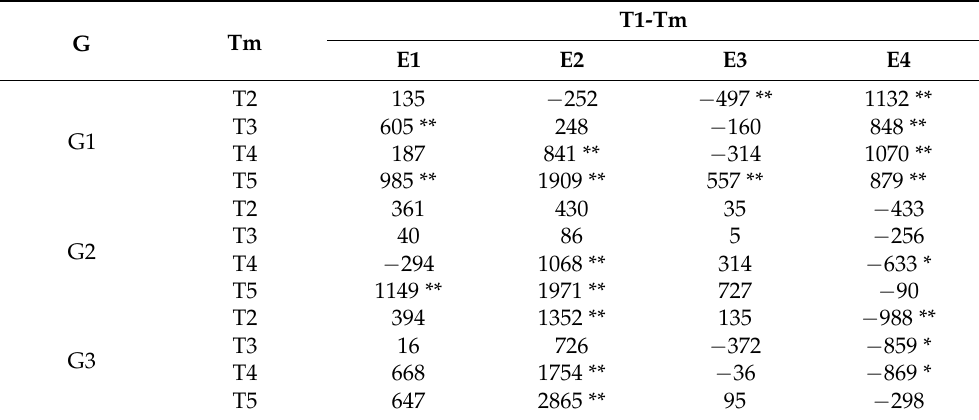
Table 9. Joint effect of genotype × year–location interaction on yield losses (kg/ha) in different defoliation treatments.